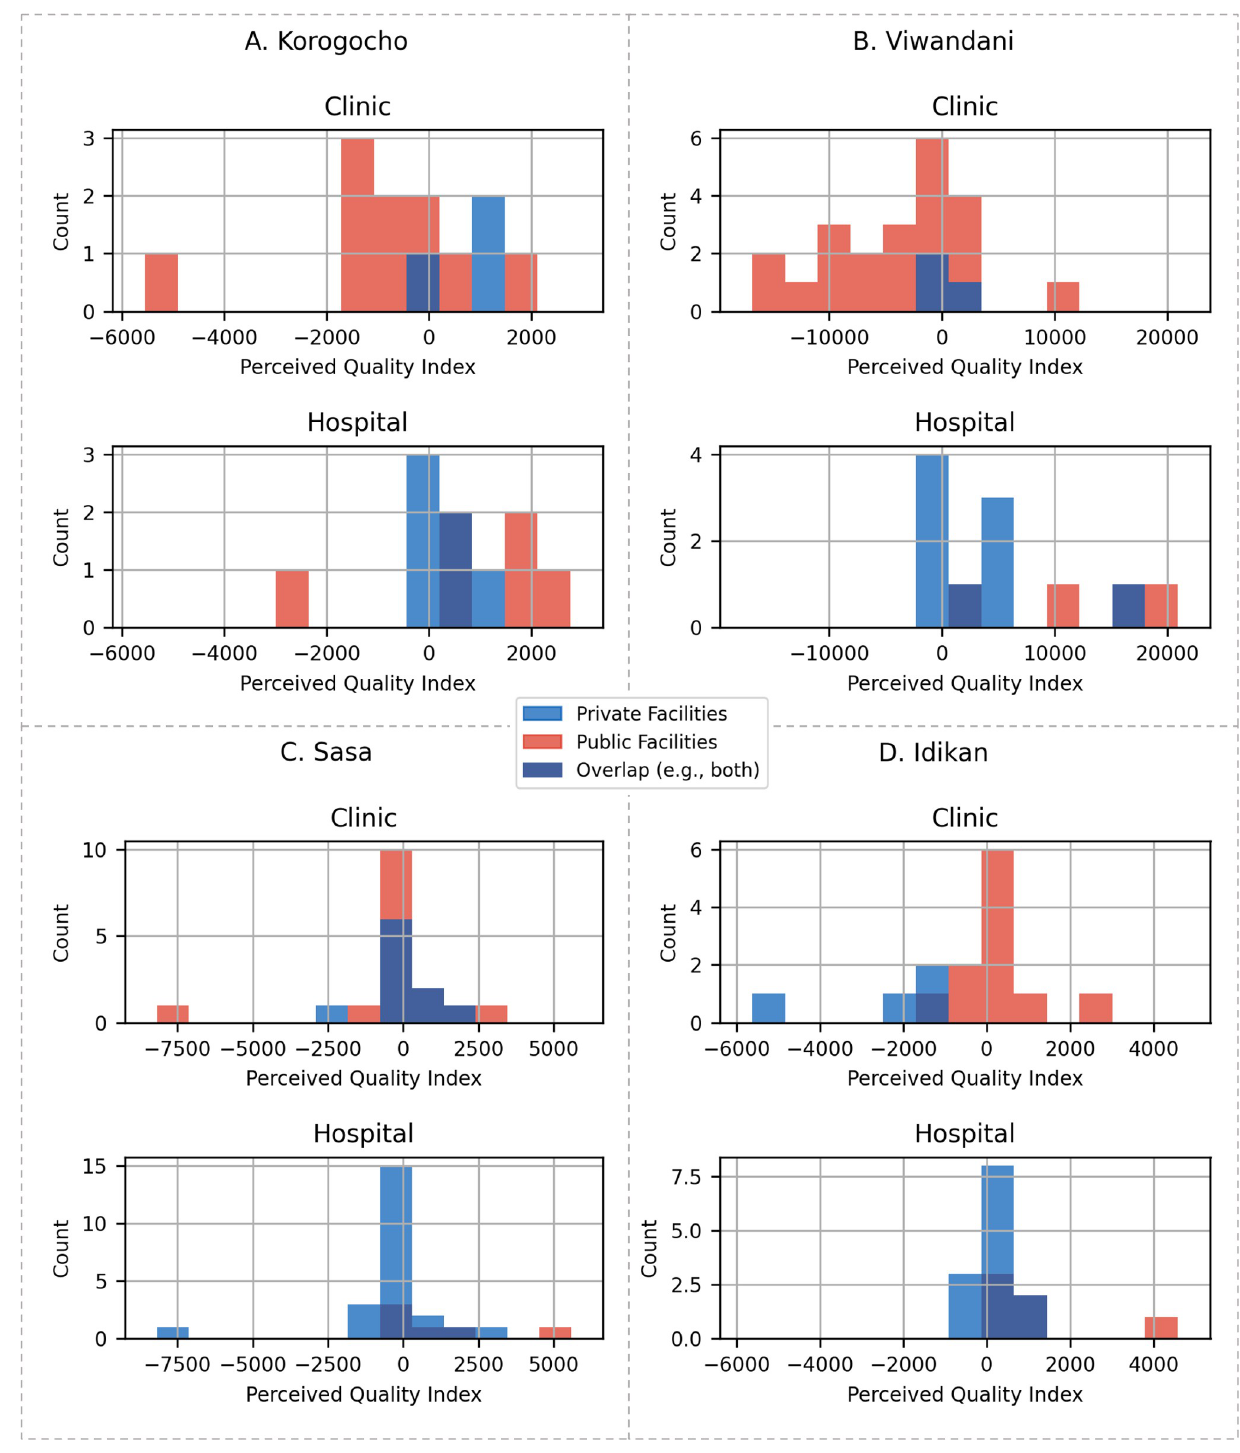
Fig 8. Histogram of distribution of PQI for HCPs in each slum.